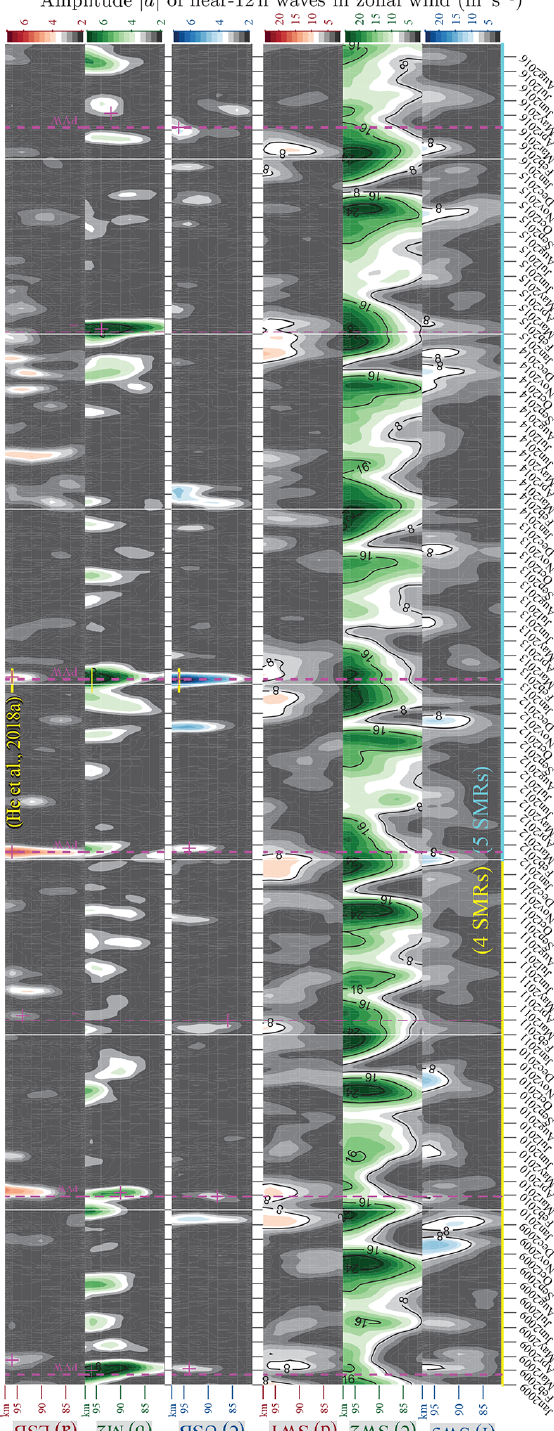
Figure 3. (a) The amplitude of the lower sideband (LSB) of the nonlinear modulation of the 16d wave on the semidiurnal tide SW2 as a function of time and altitude. (b–f) The same plots as (a) but for the lunar tide M2, the upper sideband (USB), and the solar tides, SW1, SW2, and SW3. (g) The altitude averages of panels (a) , (b) , and (c) (LSB, M2, and USB), and (h) those of panels (a) , (b) , and (c) (SW1, SW2, and SW3). In each panel, the solid white vertical lines display the first day of each year, and the dashed magenta lines display PVWs. In (f) , the cyan line on the bottom illustrates the interval from 2012 to 2016 in which all decomposition is based on five SMRs, whereas the yellow line represents that MSR observations are not available at Mohe. In (a) – (c) , the magenta plus symbols illustrate the maximum amplitude in each 30d window following each